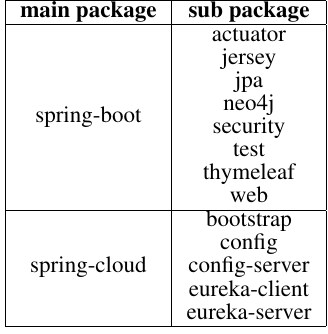
Table 1. Main Spring packages used for the microservice